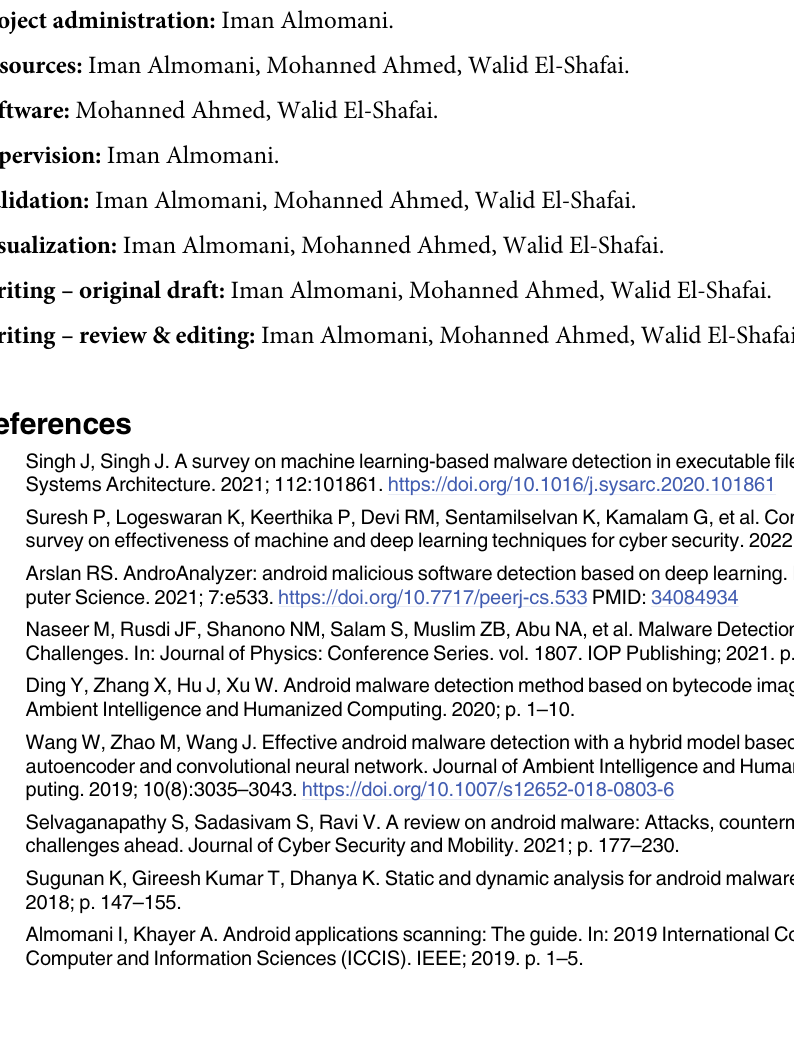
S2 Table. Security performance of models on AMD dataset based on other metrics.